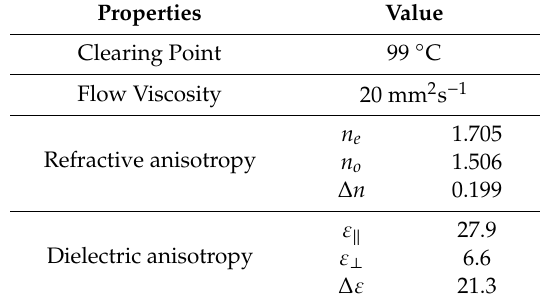
Table 1. Properties of the liquid crystal (BHR71200-100).